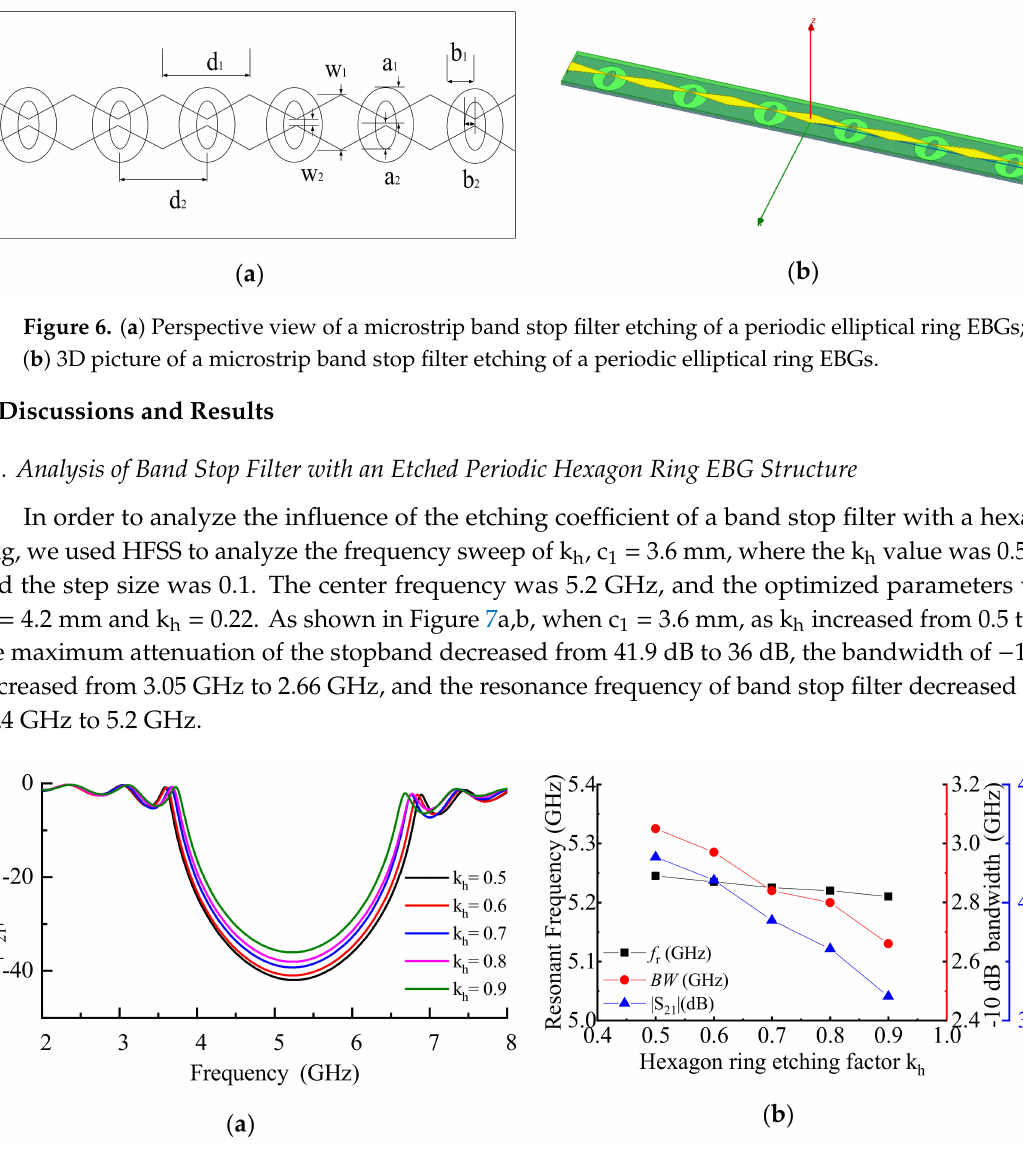
Figure 7. ( a ) Simulation with di ff erent hexagon ring etching factors k h using HFSS; ( b ) maximum attenuation and − 10 dB fractional bandwidth with di ff erent hexagon ring etching factors k h